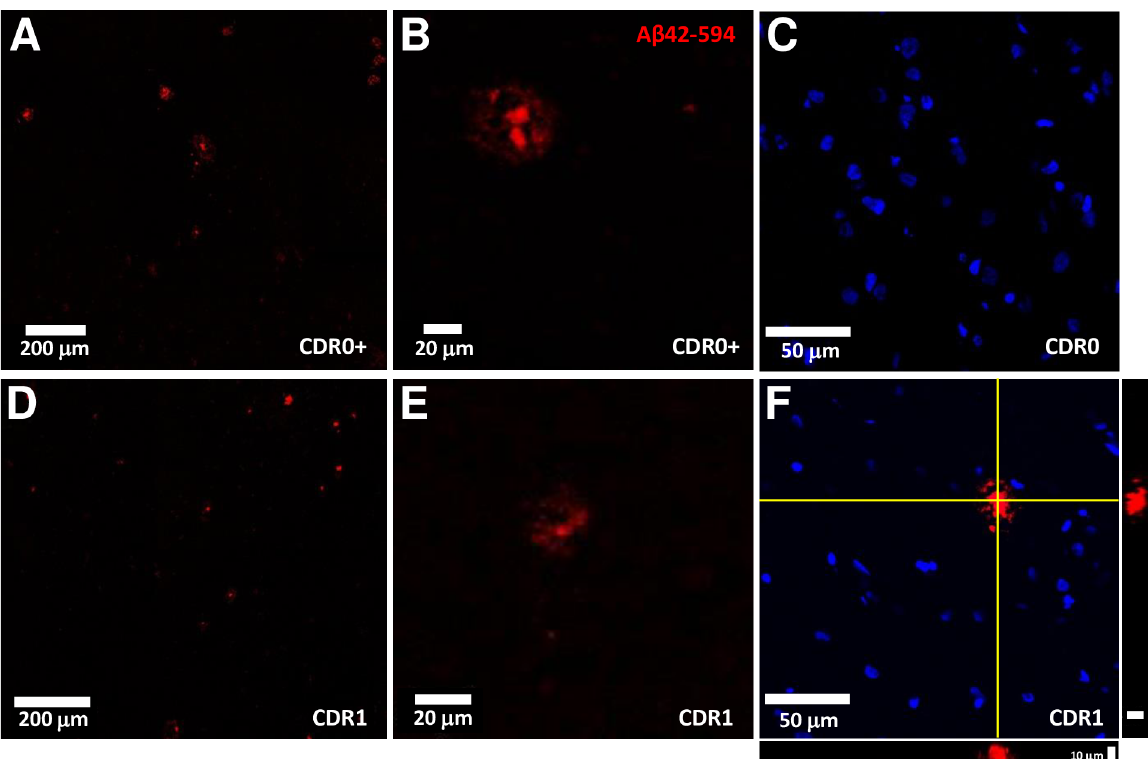
Fig 2. Exemplar fluorescent confocal microscopy of A β 1-42 -biotin binding to unfixed, frozen frontal cortex sections. ( A, D ) Representative fluorescent confocal images of labelled (streptavidin-Alexa594, red channel) A β 1-42 -biotin binding in elderly high-pathology controls (CDR0 + plaques) and elderly subjects with mild ADD (CDR1). Scale bar = 200 μ m. ( B, E ) Higher magnification confocal images reveal distinct plaque morphology and minimal background fluorescence in both in elderly high-pathology controls (CDR0 + plaques) and elderly subjects with mild ADD (CDR1). Scale bar = 20 μ m. (C) Fluorescent images of labelled (streptavidin-Alexa594, red channel) A β 1-42 -biotin binding display an absence of plaque structure morphology with minimal background signal in cognitively normal elderly subjects without plaque pathology. Nuclei stained with DAPI (blue channel). Scale bar = 50 μ m. (F) Fluorescent images of labelled (streptavidin-Alexa594, red channel) A β 1-42 -biotin binding display punctate staining of a central core with peripheral decoration in elderly subjects with mild ADD (CDR1). Nuclei stained with DAPI (blue channel). Scale bar = 50 μ m. Orthogonal XZ and YZ views, centered on the yellow crosshairs, demonstrate the labelling extent through the tissue section. Scale bar = 10 μ